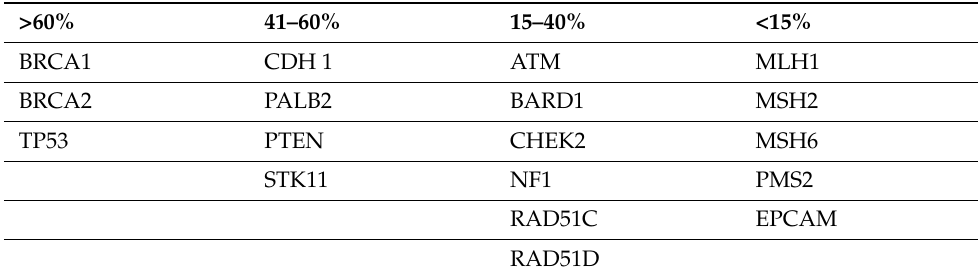
Table 1. Absolute lifetime risk for BC according to NCCN